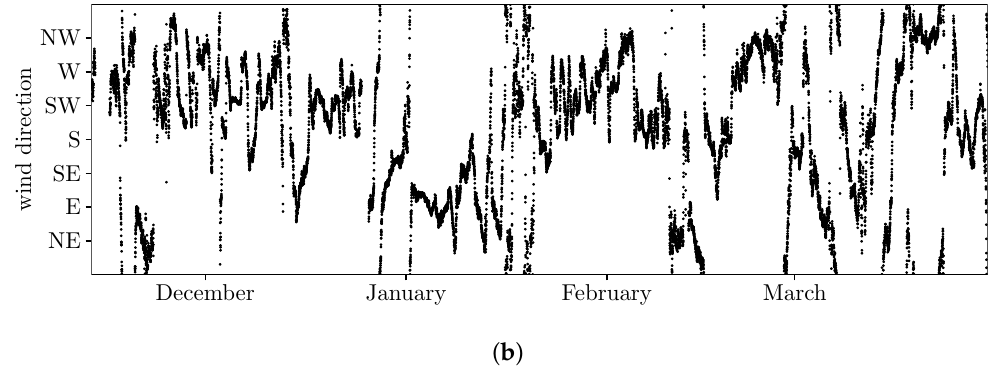
Figure 5. The wind speed ( a ) and the wind direction ( b ) at 100 m from m easurements of the Høvsøre meteorological mast during RUNE.